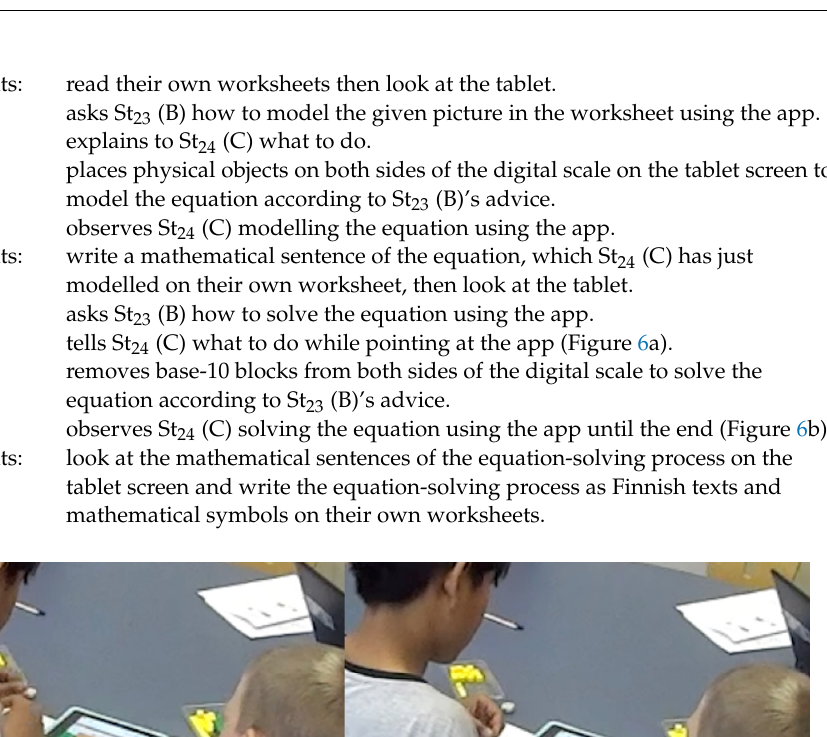
Figure 7. Peer scaffolding. St 15 (A) (in front) showing and telling St 16 (B) (in back) how to solve the equation with the app while St 16 (B) is watching what St 15 (A) is doing. Two types of collaboration, doing together and turn taking, were typically observed in the tangible-app condition. In the first type of collaboration, students used the app to